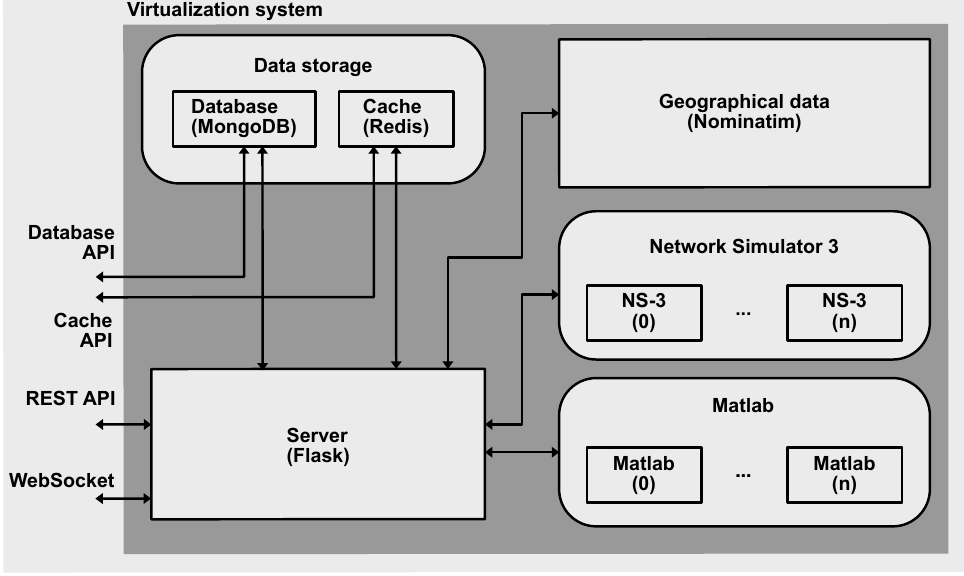
Figure 6. Program architecture diagram with terminal